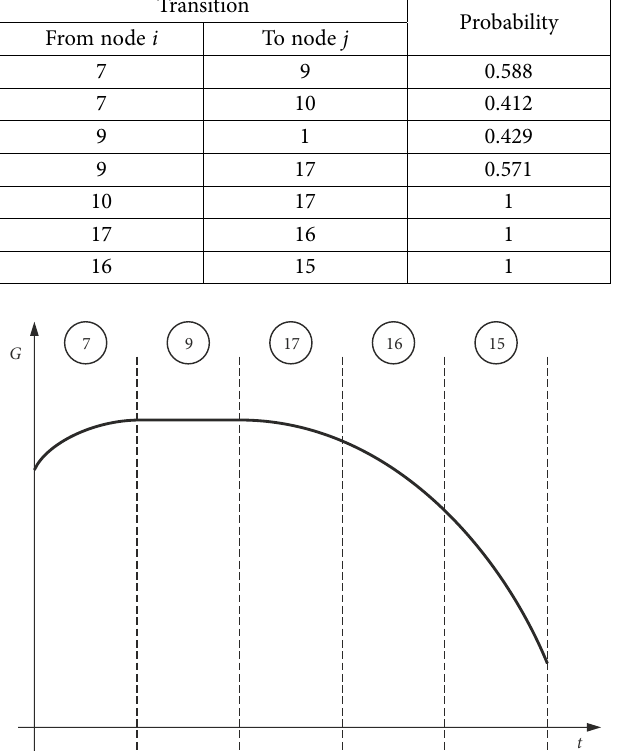
Table 9. Transition probabilities (source: elaborated by the authors)